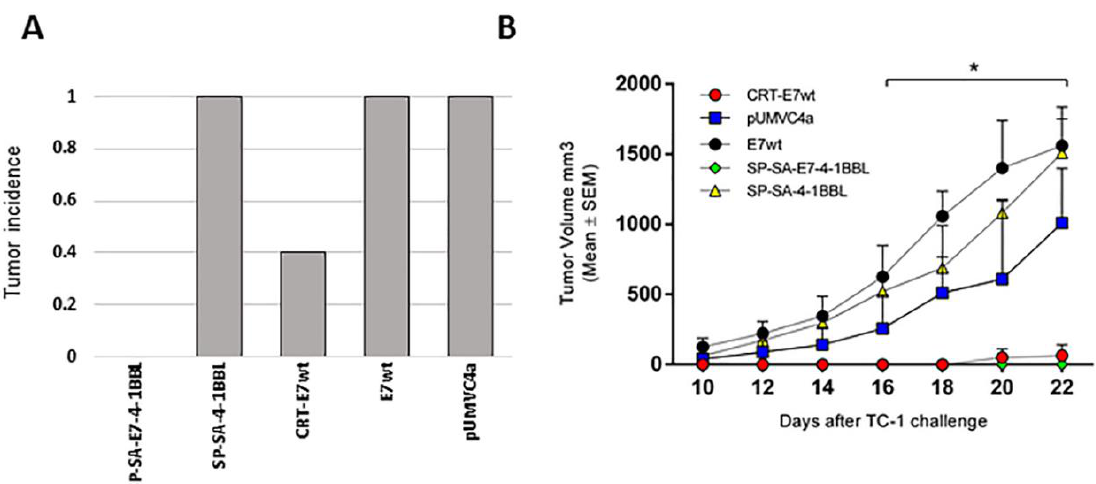
Figure 2. Immunization with the SP-SA-E7-4-1BBL DNA vaccine shows prophylaxis against TC-1 tumor: ( A ) Endpoint tumor incidence. Groups (n = 5) of five 5- to 6-week-old C57BL/6 mice were immunized on shaved abdominal skin with 1 µg of DNA using gene gun system, and a week later challenged with 5 × 10 4 TC-1 cells in the right flank by subcutaneous injection. Tumor incidence is subcutaneous injection of TC-1 cells in C57BL/6 mice. Tumor volumes are represented by mean